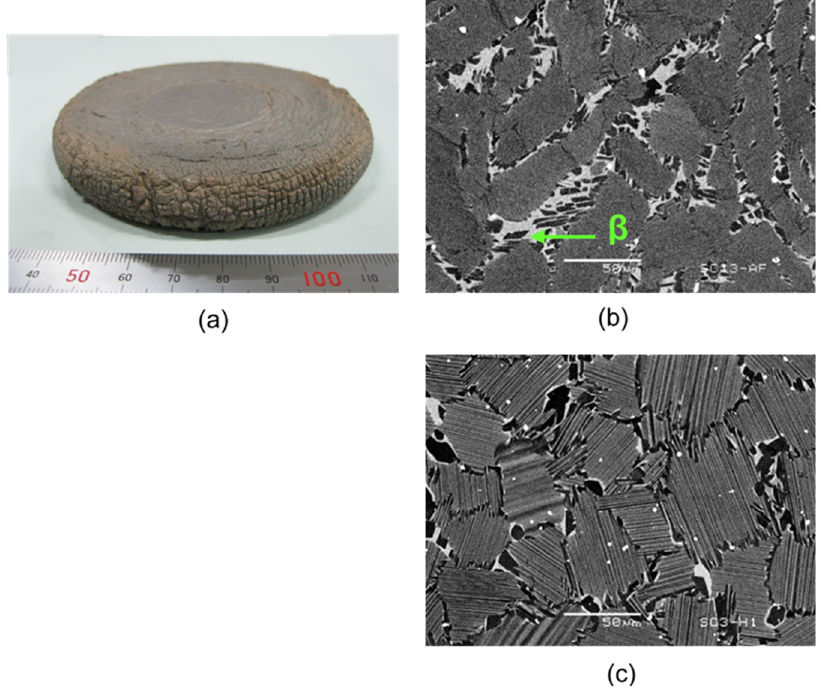
Figure 12. Hot-forging test results and microstructures before and after heat treatment of the newly developed alloy. ( a ) Appearance of the hot-forged material. ( b ) As-forged microstructure. ( c ) Microstructure after heat treatment.